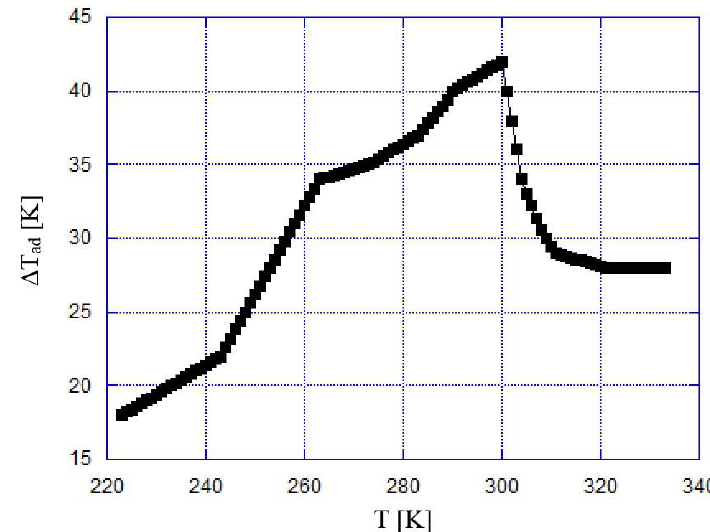
Table 1. Thermal and physic features of acetoxy silicone rubber.